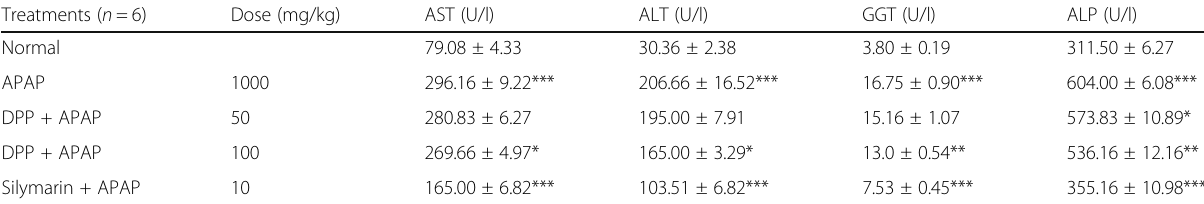
Silymarin + APAP All values represent mean ± SEM. * p < 0.05; ** p < 0.01, *** p < 0.001; ANOVA, followed by Dunnett ’ s multiple comparison